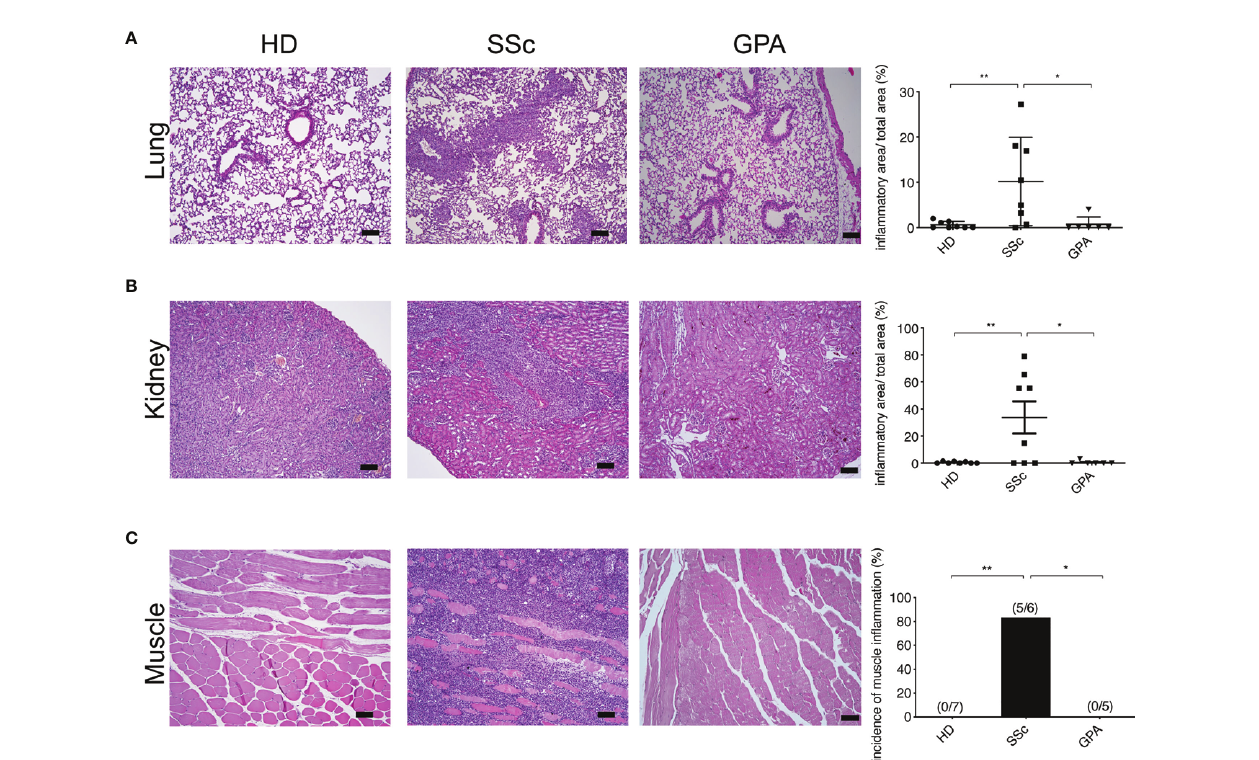
FIGURE 3 | Systemic in fl ammation in PBMC-transferred mice. In fl ammatoin in lung (A) , kidney (B) , and muscle (C) was kidney and muscle was evaluated by H&E staining in mice transferred with PBMC from healthy donors (HD), SSc patients and GPA patients. Representative histologic images are shown (bar = 100µm) in the left panel, while the right panel shows the quantitative score of in fl ammation evaluated in a blinded manner based on the ratio of in fi ltrated area to total area of the organ. The data are presented as mean ± SD and statistical analysis was performed using ANOVA (*p < 0.05, **p < 0.01).